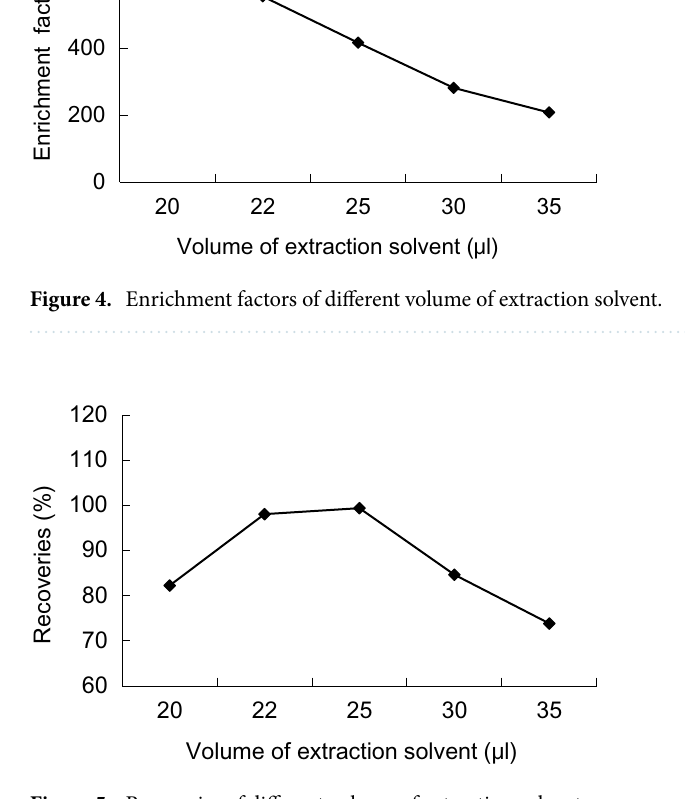
Figure 5. Recoveries of different volume of extraction